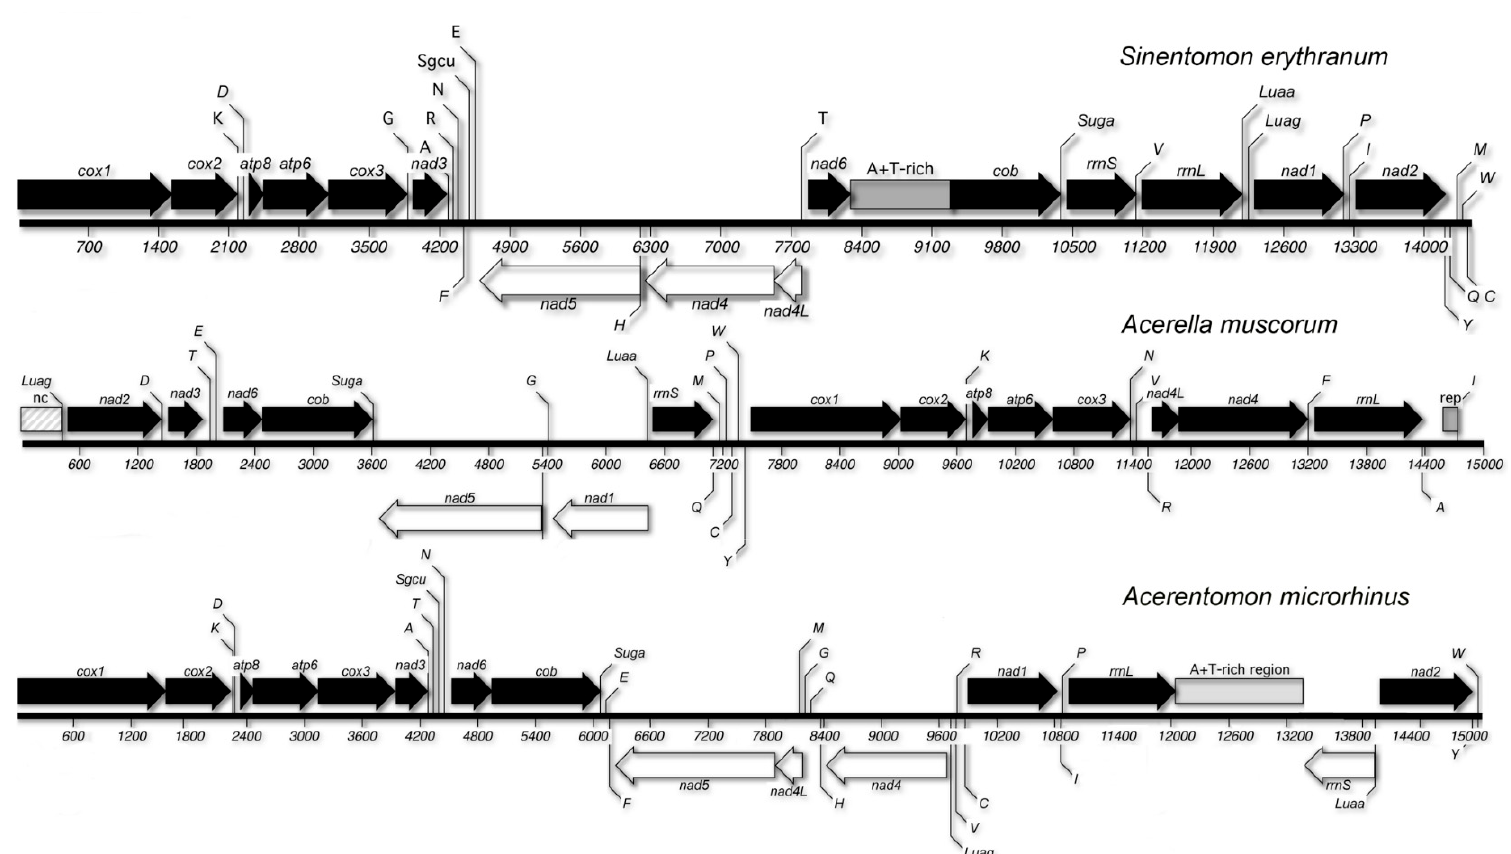
Figure 2. Linearized map of the three proturan mitochondrial genomes. Genes oriented on the J- and N-strand are represented above and below the line, respectively.